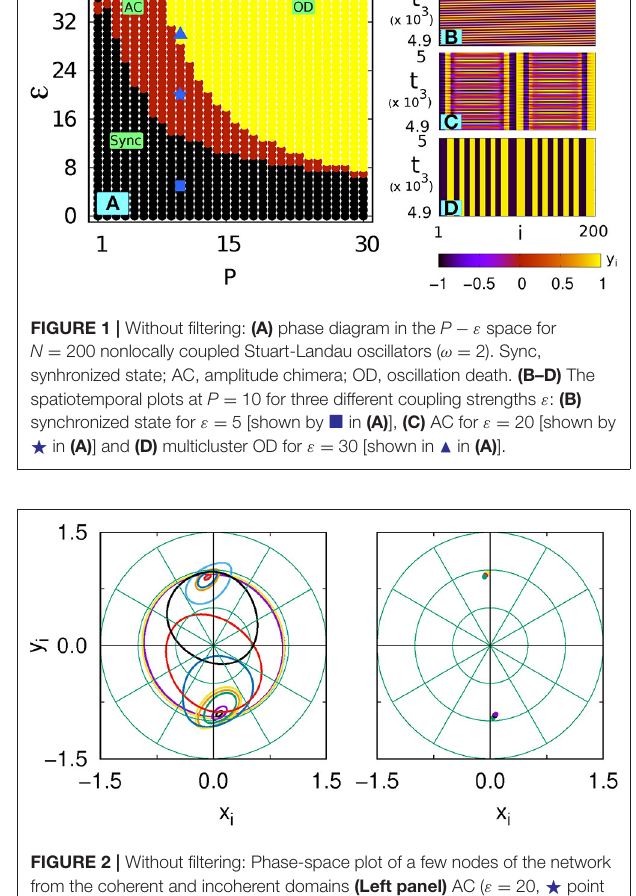
20, ⋆ point = 30, N point of Figure 1A ). Other = 10, ω 2, N = = =